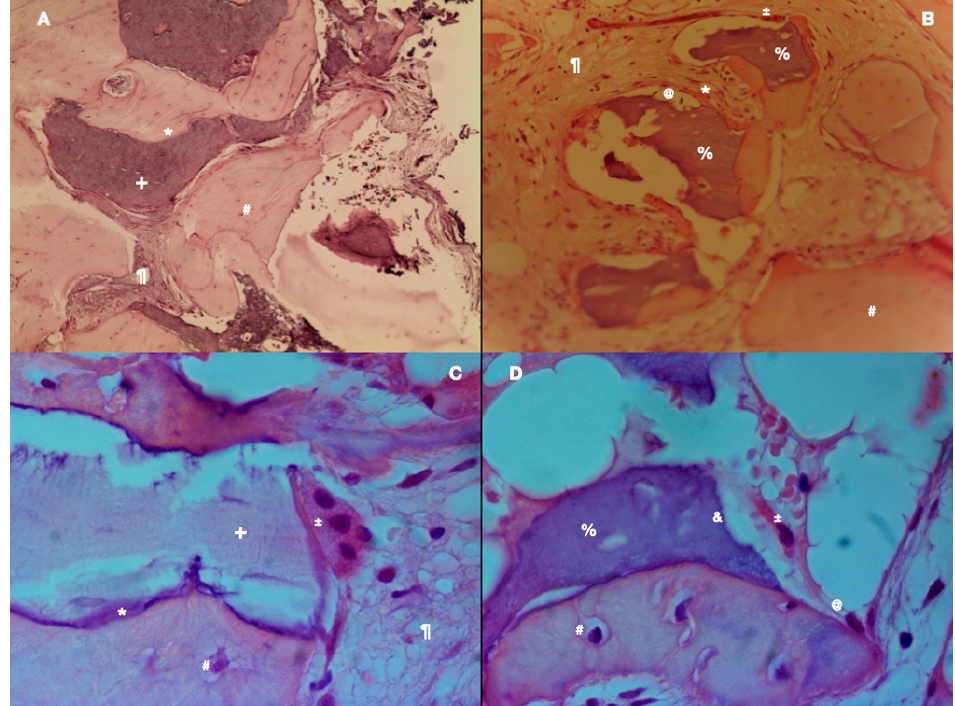
Figure 3. ( A ) Example of autologous bone graft—H&E coloration—200×. ( B ) Example of xenograft particles—H&E staining—200×. ( C ) Autologous bone graft sample—H&E staining—400×. ( D ) Example of xenograft particle in high magnification—H&E staining—400×. Legend: * immature bone, + autologous bone graft, # osteocyte, % xenograft, ¶ soft tissue, @ osteoblast, ± osteoclast, & Howship lacunae.